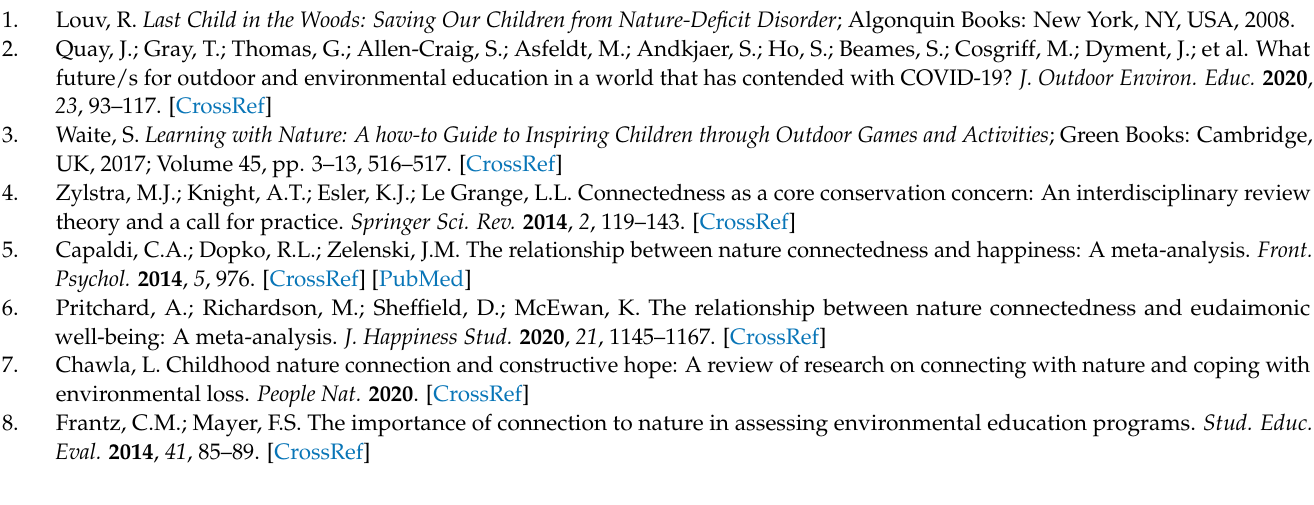
(upper matrix) pre and post. Table S2: Descriptive statistics by School. Figure S1: (A) Positive correlation of NCI with IINS; (B–D) Interaction plot of NCI, PANAS positive and negative affect as a function of